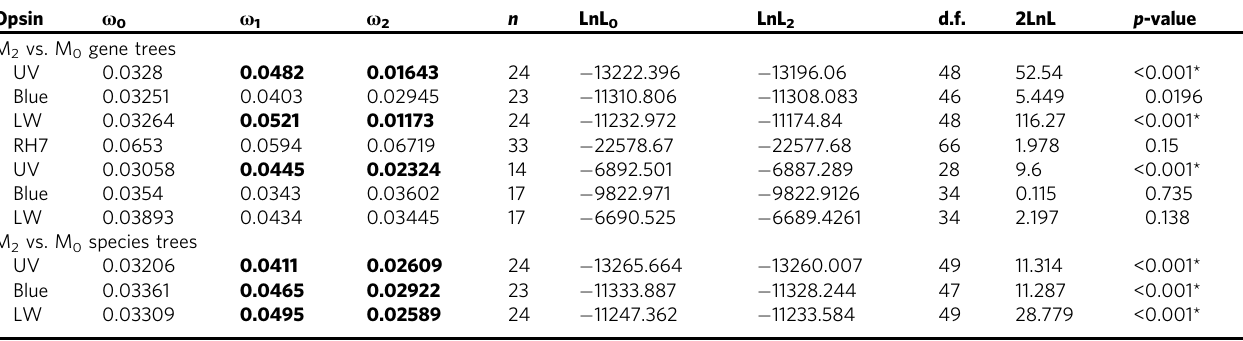
Table 2 dN/dS ( ω ) rates for null (M 0 ) and branch models (M 2 ) for UV, Blue, Long wavelength (LW), and RH7 opsins using species and gene trees and different number of taxa. Increasing the number of taxa shows signi fi cant differences between rates across nocturnal ( ω 1 ) and diurnal species ( ω 2 ) for color opsins but not for RH7 opsin, which served as a control. Opsin ω 0 ω 1 ω 2 n LnL 0 LnL 2 M 2 vs. M 0 gene trees